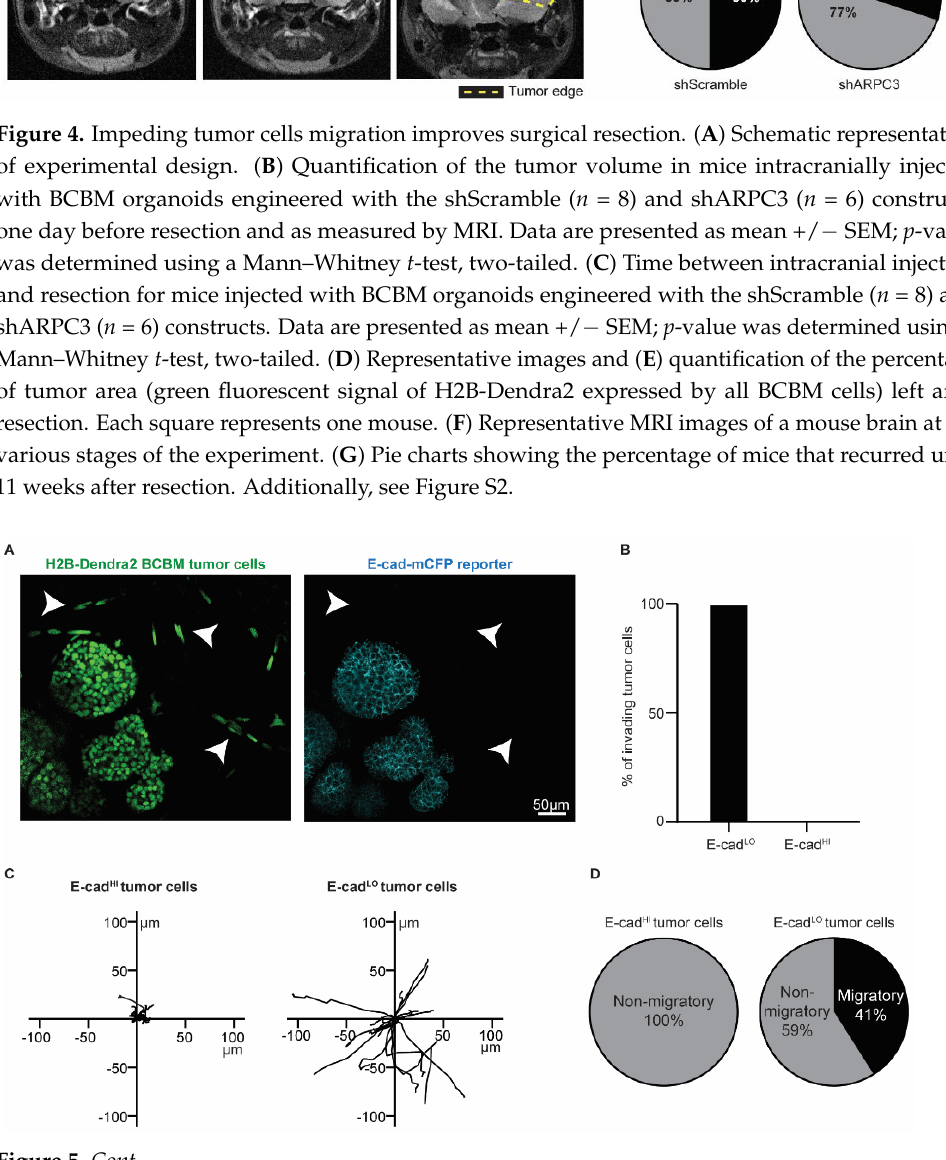
Figure 5. BCBM invading tumor cells are in a mesenchymal state. ( A ) Representative multi-photon images of BCBM tumor cells expressing H2B-Dendra2 (green) and endogenous E-cad-mCFP (tur- quoise). White arrowheads point to invading tumor cells. ( B ) Percentage of invading tumor cells that are E-cad LO and E-cad HI . ( C ) Representative rose plots of migratory tracks with a common origin of 20 E-cad HI tumor cells and 20 E-cad LO tumor cells imaged using multi-photon imaging through a cranial window. ( D ) Pie charts of migratory (speed ≥ 2.5 μm/h) E -cad HI or E-cad LO tumor cells. ( E ) Schematic representation of experimental design used for isolating E-cad HI or E-cad LO tumor cells for mRNA sequencing and RT-qPCR. ( F ) Volcano plot comparing the fold change and false discov- ery rate (FDR) of E-cad HI and E-cad LO BCBM tumor cells. ( G ) mRNA expression analysis of EMT- related genes by mRNA sequencing and RT-qPCR; n = 4 for mRNA sequencing and n = 3 for RT- qPCR with exception for Cdh2 and Zeb2, which are n = 2. Data are presented as mean +/− SEM and standard deviation (SD) for Cdh2 and Zeb2. p -values were determined with a one-sample t-test,